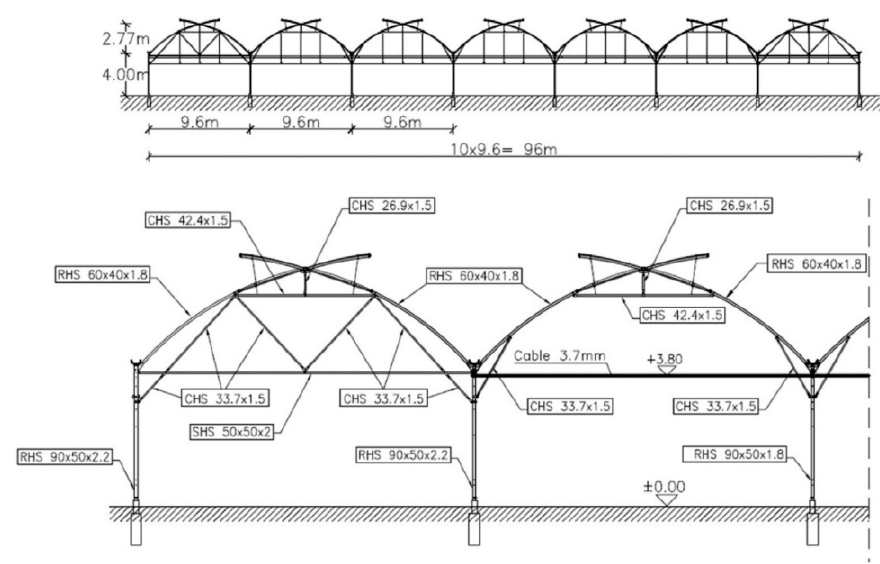
Figure 8. Typical frame of vaulted greenhouse [14].